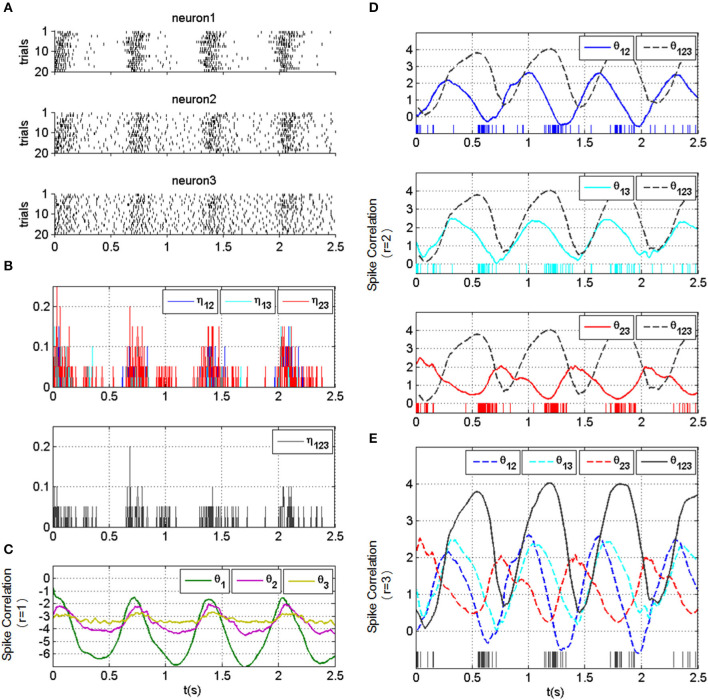
Estimation of spike correlations for acupuncture data evoked by twirling reinforcing. (A) Ensemble spike activities. The number of neurons is N = 3 and the number of trials is n = 20. (B) Rates of joint spike: η12, η13, η23, and η123. (C) First-order spike correlations: θ1, θ2, and θ3 (green, pink, and yellow solid lines). (D) Second-order spike correlations: θ12, θ13, and θ23 (blue, cyan, and red solid lines). (E) Third-order spike correlation: θ123 (gray solid line). Raster with different colors at the bottom show the timing of corresponding order synchronous spikes.